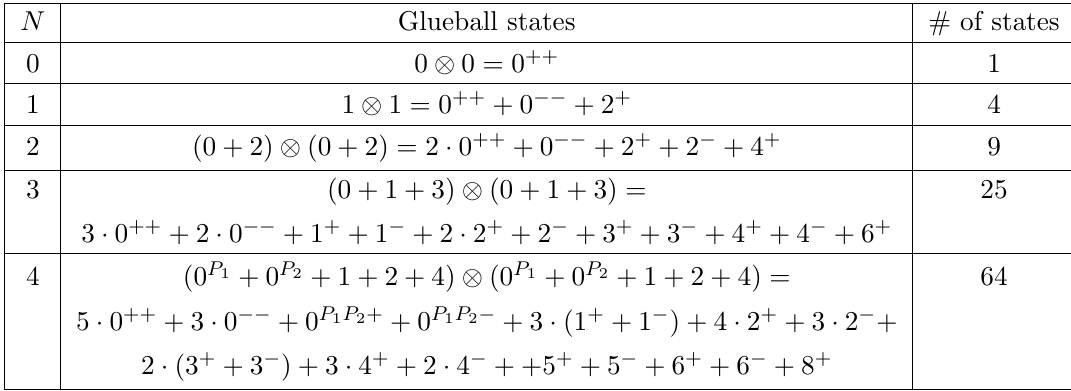
Table 1. Quantum numbers of 3D glueballs at (cid:12)rst (cid:12)ve levels, as predicted by the ASA.